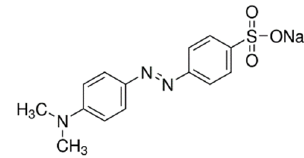
Figure 1. Methyl Figure 1. Methyl orange.